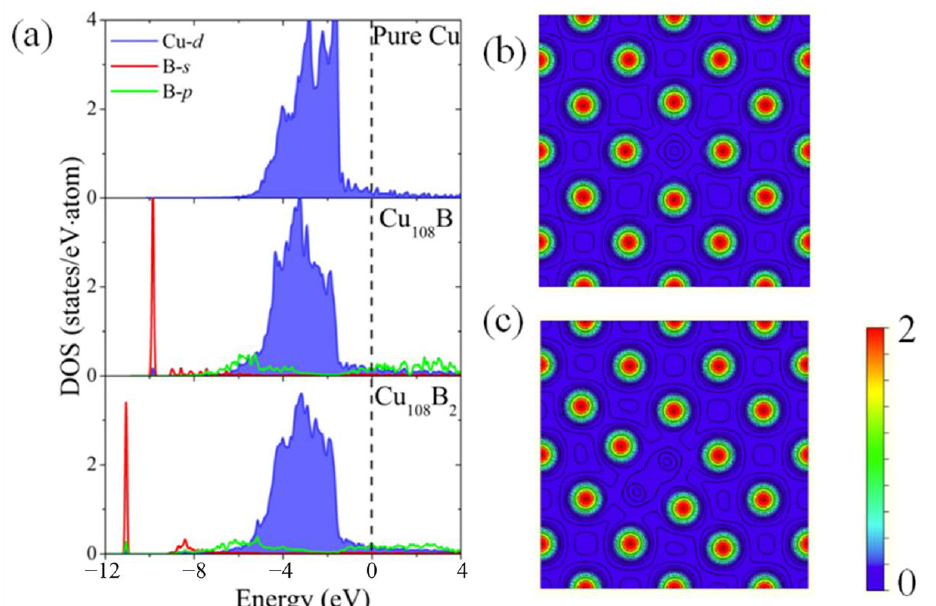
Figure 5. ( a ) Density of states (DOS) for pure copper, one boron atom at OIS (Cu 108 B) and two boron atoms at the nearest OISs (Cu 108 B 2 ). The dotted line represents the Fermi level. ( b , c ) The valence charge densities of the (001) plane for Cu 108 B and Cu 108 B 2 , respectively. Contours start from 0.025 e/a.u. 3 , and increase successively by a factor of 10 1/5.